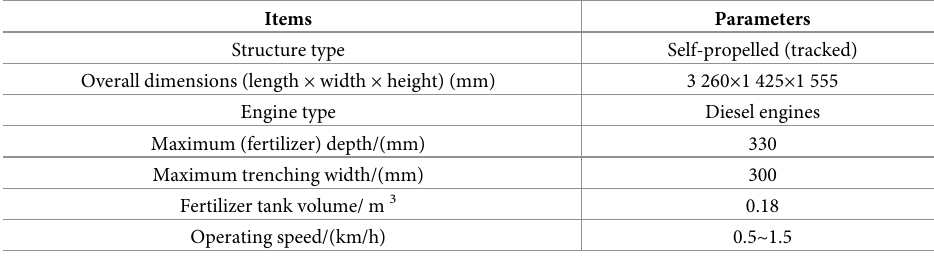
Table 1. Technical parameters of the